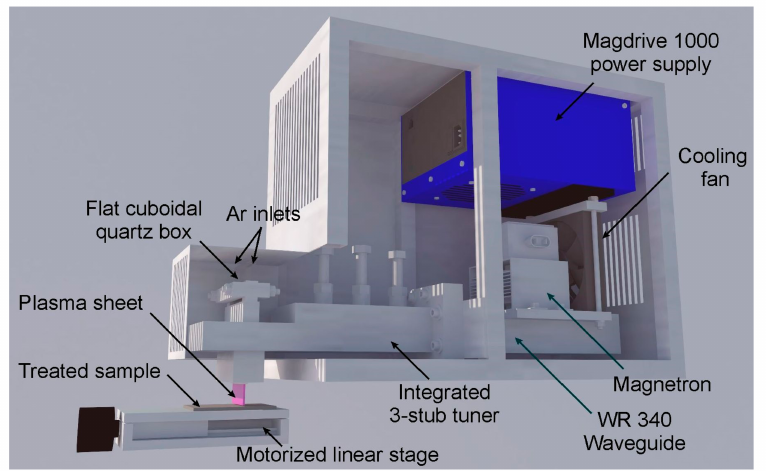
Figure 2. Schematic representation of the novel microwave plasma source for surface modification of polycarbonate